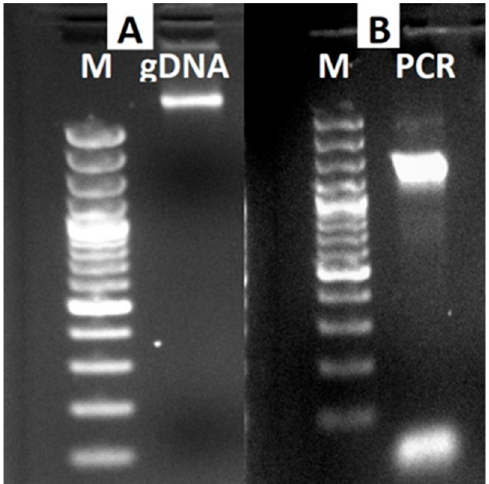
Figure 5. ( A ) Agarose gel (1.5%) electrophoresis results of genomic DNA of O. neapolitana isolated from mucilage (M: Marker, DNA: gDNA of O. neapolitana isolate TR2 (OQ220476)) and ( B ) agarose gel (1%) electrophoresis result in which 18S primers were used (M: Marker, PCR: amplification product of O. neapolitana isolate TR2 (OQ220476)).